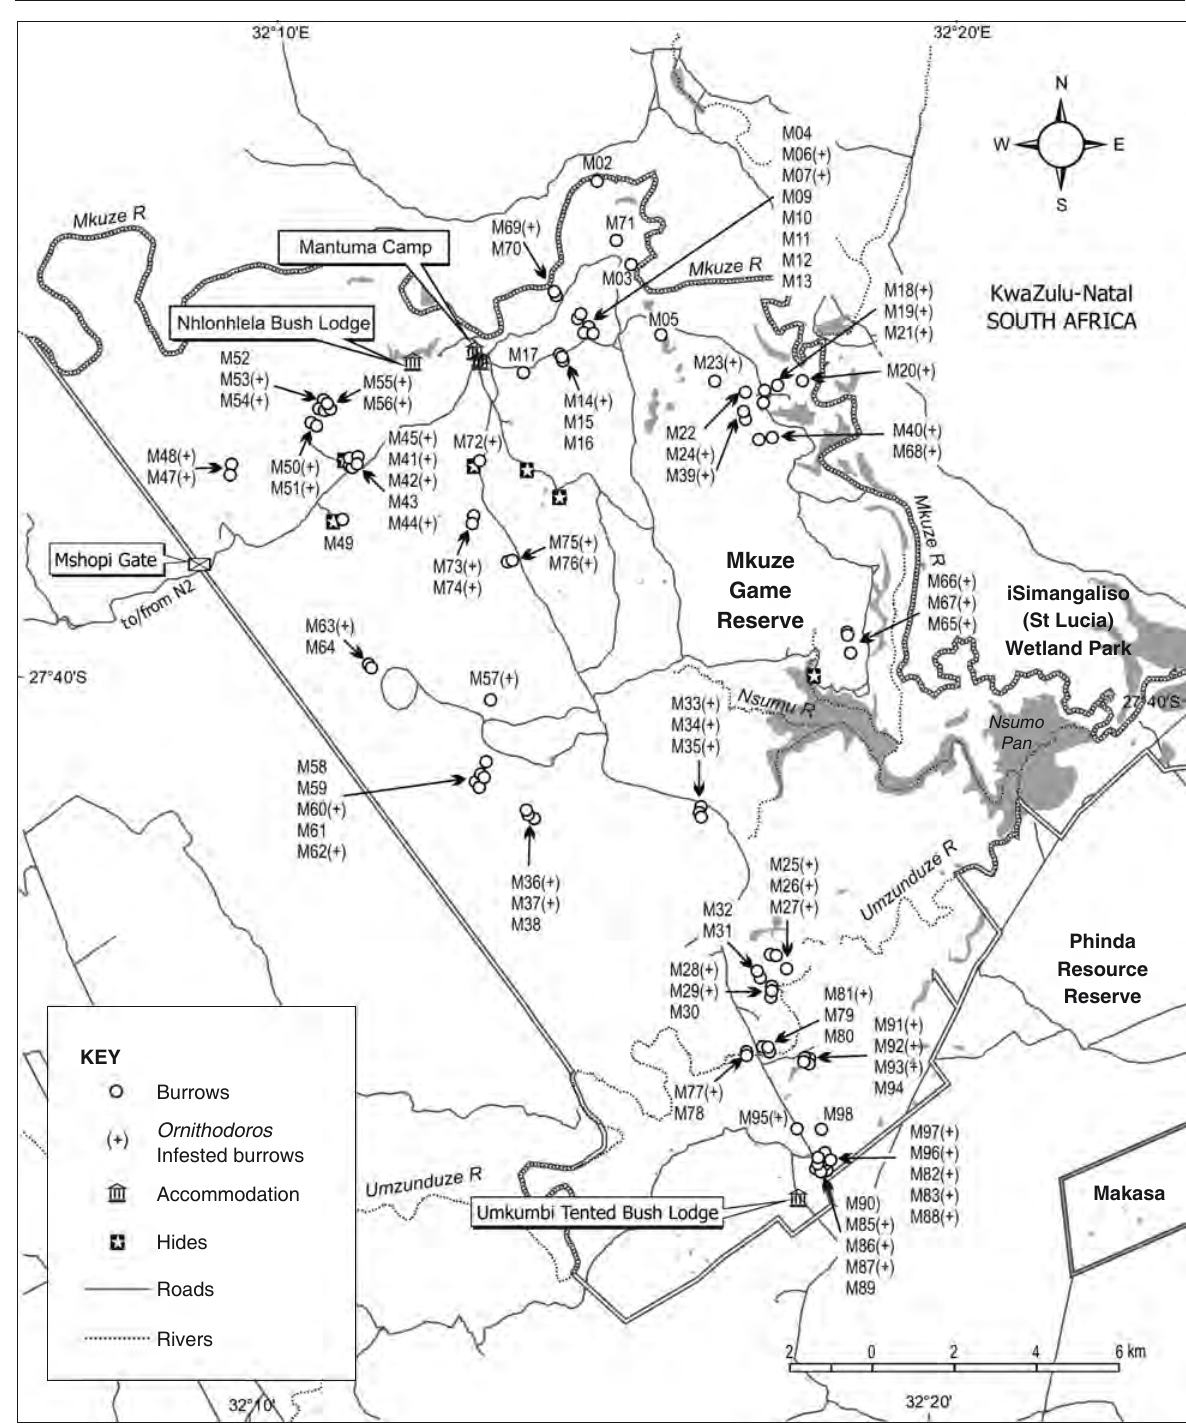
FIG. 1 Map of Mkuze Game reserve depicting the distribution of the 98 warthog burrows (M1–M98) investigated for the presence of